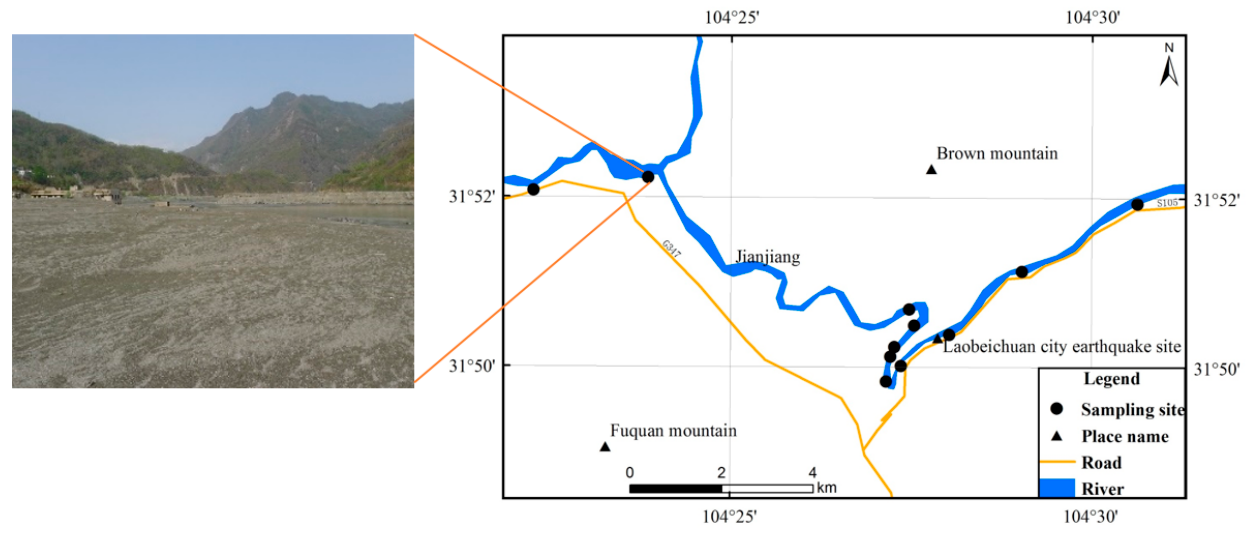
Figure 1. Study area with a picture of the sampling site.